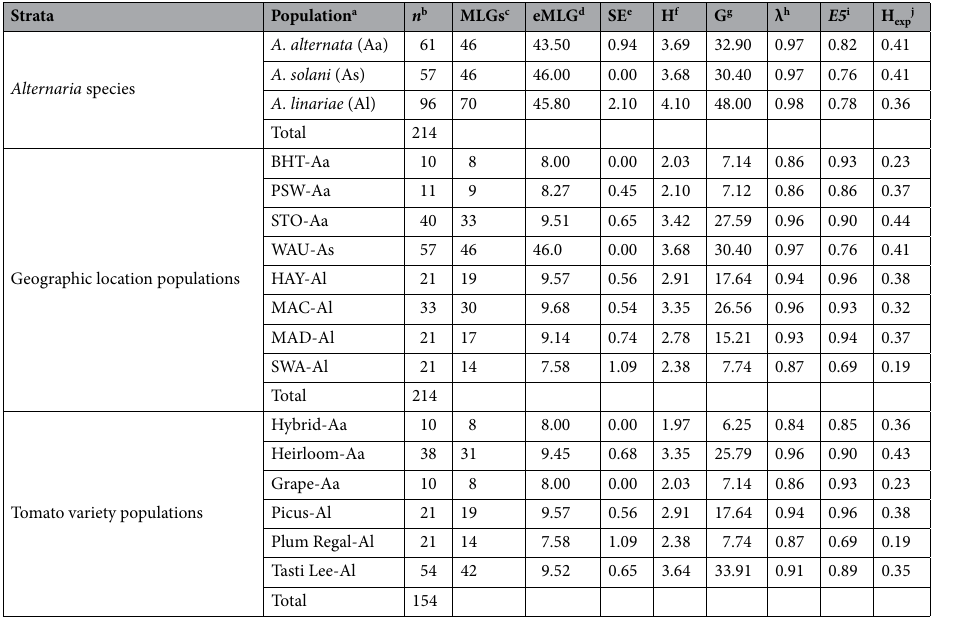
Table 1. Indices of genotypic diversity on clone-corrected datasets for Alternaria alternata (Aa), A. solani (As), and A. linariae (Al) populations collected from tomato and potato in North Carolina and Wisconsin analyzed using 220 single nucleotide polymorphisms (SNPs) from 10 microsatellite loci. a Populations of Alternaria species were defined in the methods. b n = Number of individual samples. c MLG = Number of multilocus genotypes (MLG) observed. d eMLG = The number of expected MLG at the smallest sample size 10 based on rarefaction. e SE = Standard error based on eMLG. f H = Shannon–Wiener genotypic diversity 77 . g G =